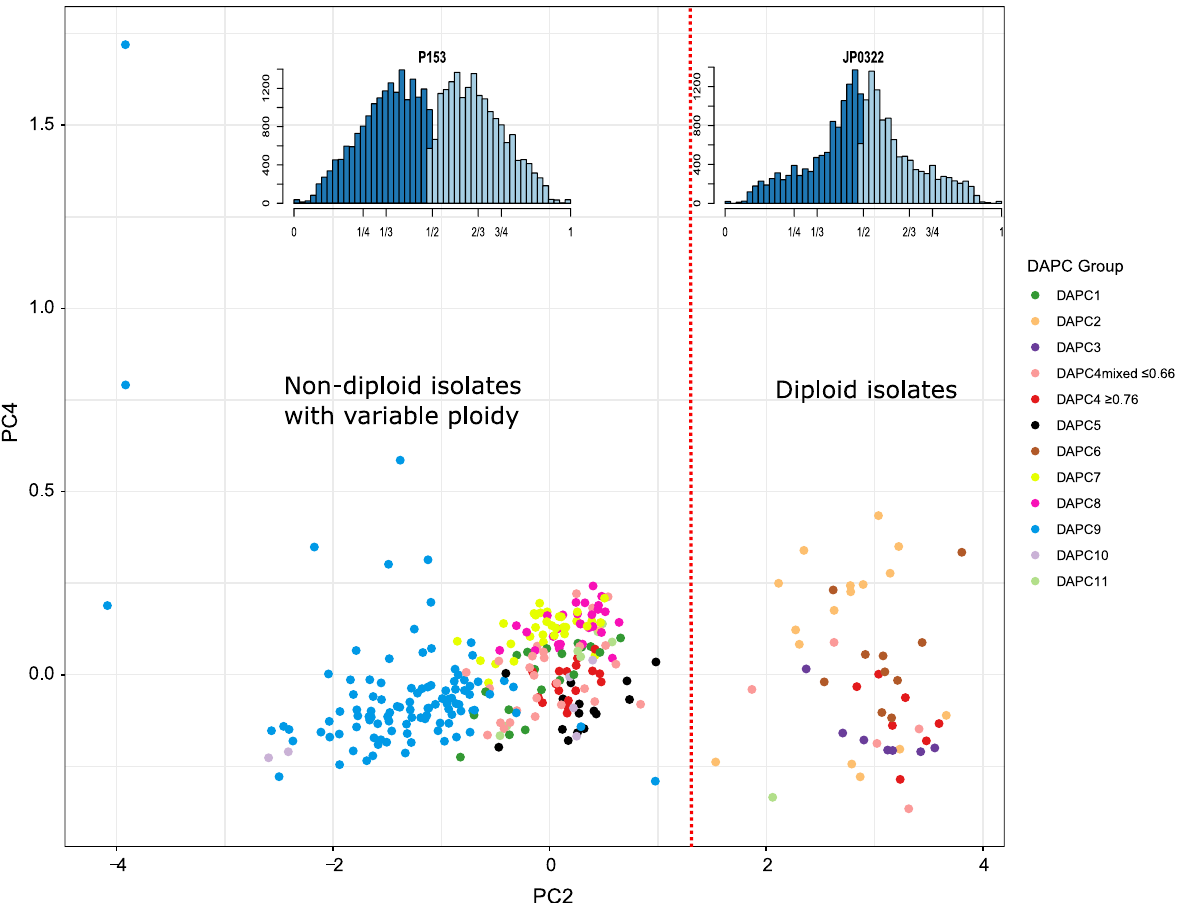
Fig. 6 Principal components analysis of allelic ratios of heterozygous SNPs using gbs2ploidy showing two ploidy levels are present in the set of P. cambivora -related isolates. The vertical dashed line separates diploid isolates (on the right) from non-diploid isolates (on the left). Inset plots × show the distribution (histogram) of allele balance values for two example P. cambivora isolates. JP0322 (DAPC2) shows a typical diploid plot; P153 × (DAPC4mixed 0.66) shows a typical triploid plot. The frequency of the most abundant heterozygous allele is displayed in light blue, the frequency ≤ of the second most abundant heterozygous allele is displayed in dark blue. Expectations of the allele balance are displayed on the